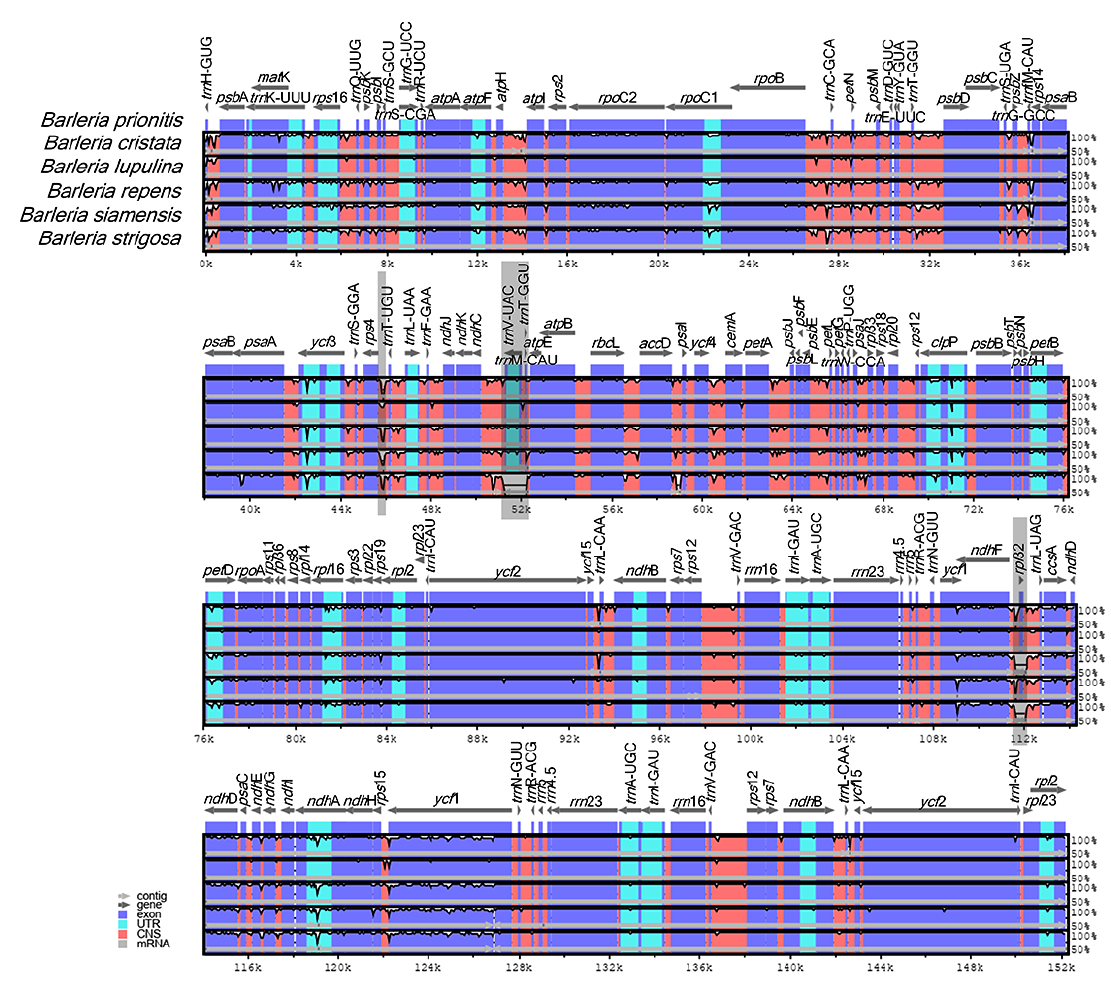
Figure 4. Sequence alignment comparison of the Barleria chloroplast genome using mVISTA, with B. prionitis as a reference. The purple bars represent exons; the pink bars represent non-coding sequences (CNS); the light-blue bars represent tRNA and rRNA regions; the gray arrows above the aligned sequences indicate the genes and their orientations; the x-axis represents the number of bases in the aligned sequences; the y-axis represents the percent identity from 50 – 100%; the dark gray bars indicate variation regions in the genomes.